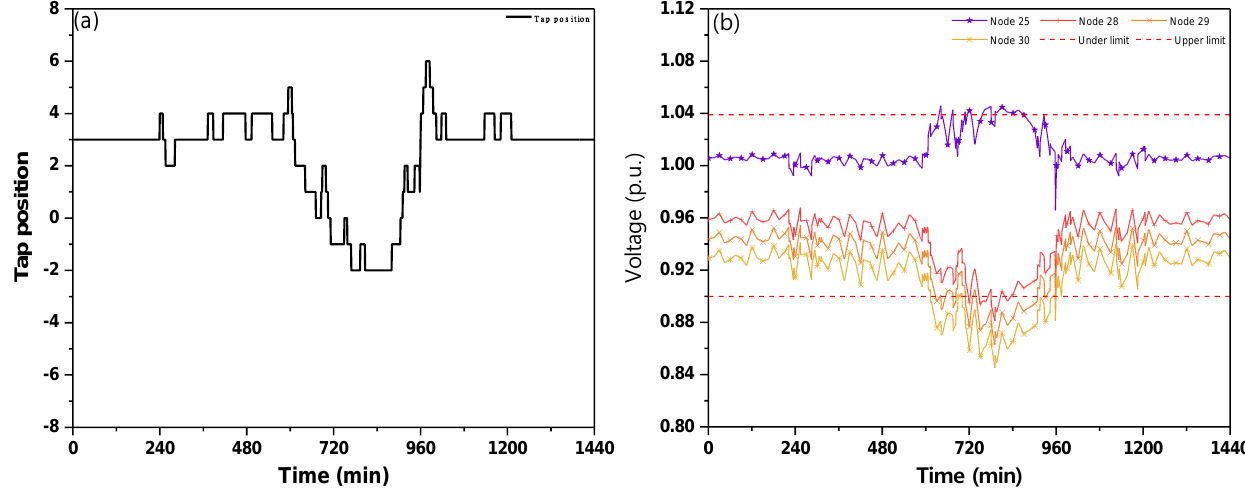
Figure 12. Simulation results of Case 5: ( a ) tap position and ( b ) feeder voltages. Based on the results, setting the reference voltage and point is required to solve the voltage problem. Figure 13 shows the voltage of the PV-connected line (Feeders 1–5) based on the proposed method (Case 6). In the forward power flow, the OLTC was operated based on the heavy load line with the largest voltage difference to solve the low-voltage problem. In the reverse power flow, the OLTC was operated as a PV-only connected line to solve the over-voltage problem. However, due to the delay time of OLTC, an over-voltage occurs in Feeder 5, which is only connected to PVs.